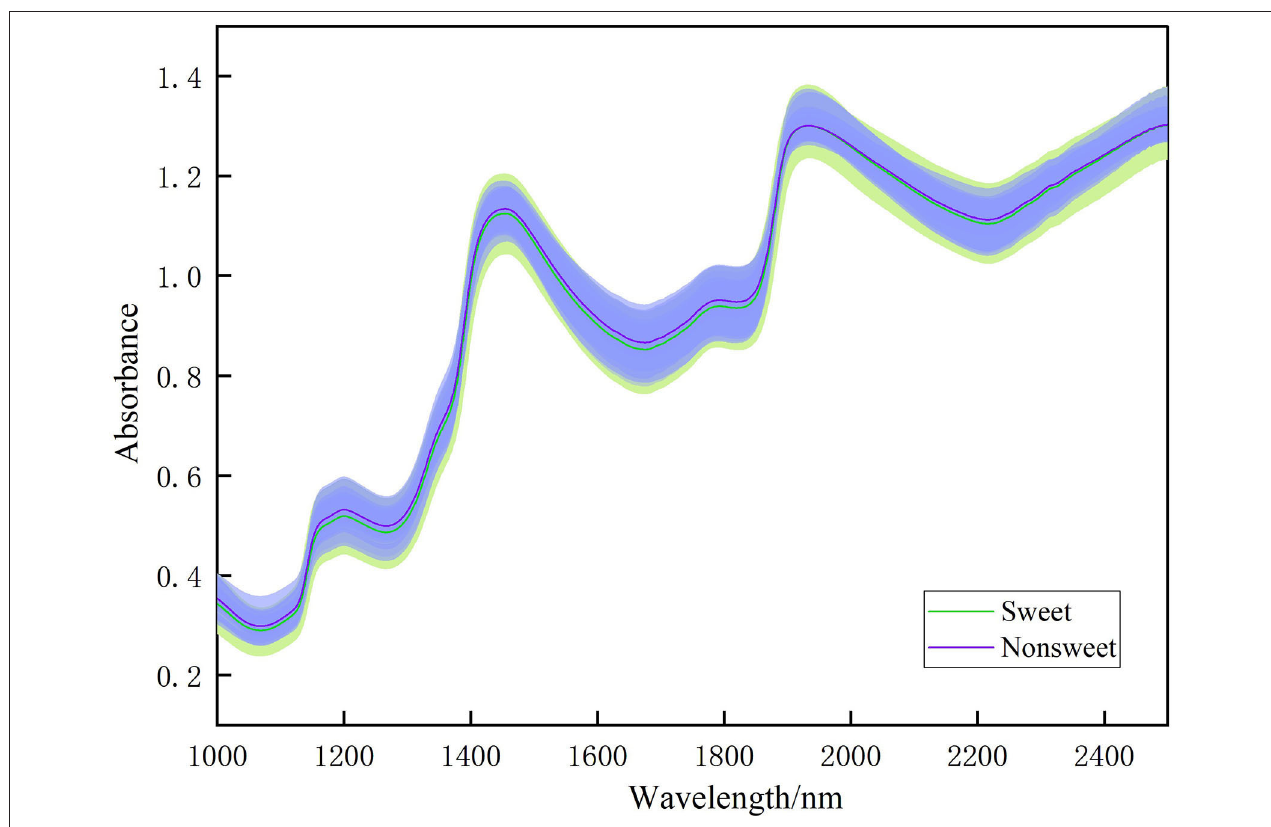
FIGURE 4 | Comparison of NIR spectra of sweet (SSC beyond 9 Brix) and unsweet (SSC below 9 Brix) fruit samples. The shaded areas represent the confident intervals to each